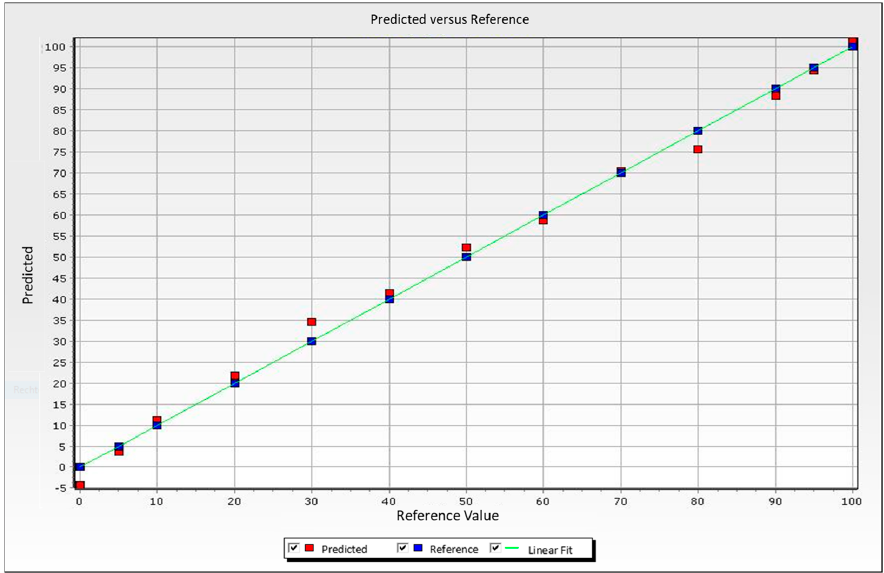
Figure 25. PLSR calibration curve for zinnwaldite–quartz mixtures. Using the cluster calculation, the following four clusters containing different lithium contents based on zinnwaldite can be generated (Figure 26).